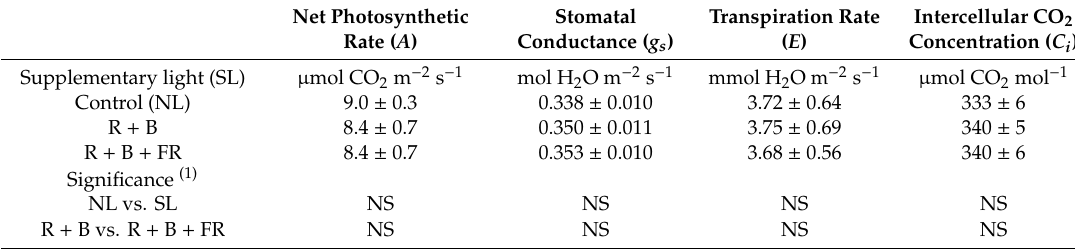
Table2. Effectsoflightconditionsonphotosynthesisnetrate(A, µ molCO 2 m − 2 s − 1